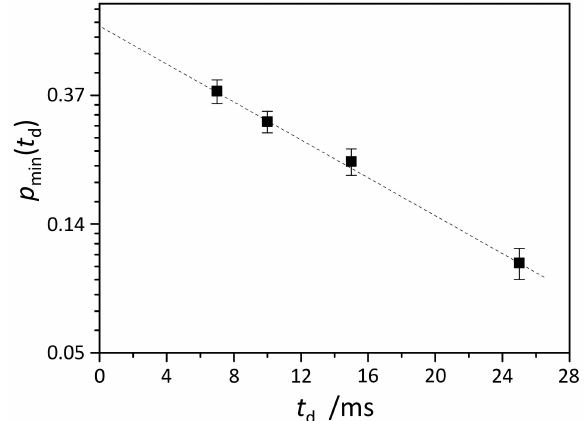
Figure 9. The dependence of the population factor p min on the di ff usion time t d obtained from the analysis of the di ff usion attenuations measured for 5-FU molecules in equimolar mixture with β -CD in aqueous solution at 298 K. The dotted line was fitted using Equation